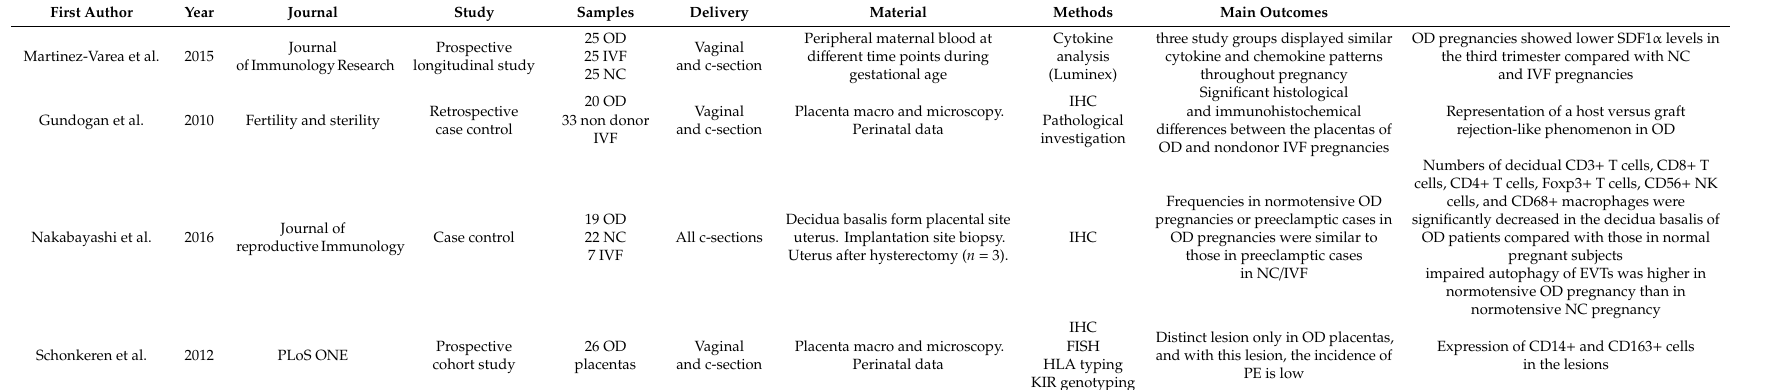
Table 1. Overview of the articles selected in this systematic